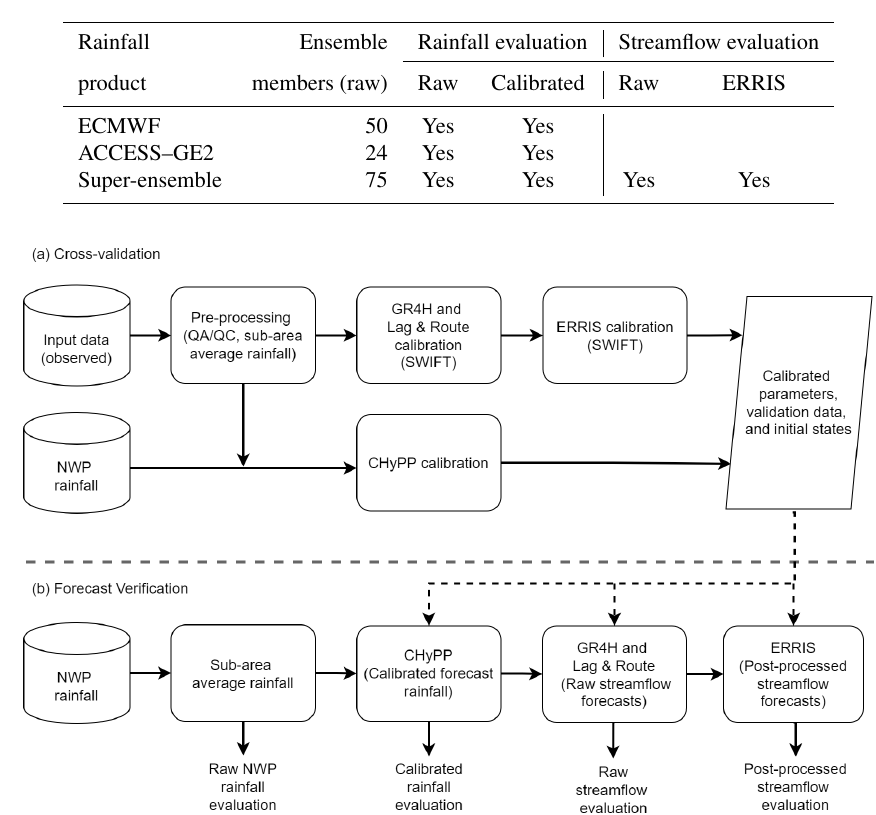
Figure 1. Rainfall and streamflow forecast evaluation framework: (a) cross-validation and (b) forecast verification.